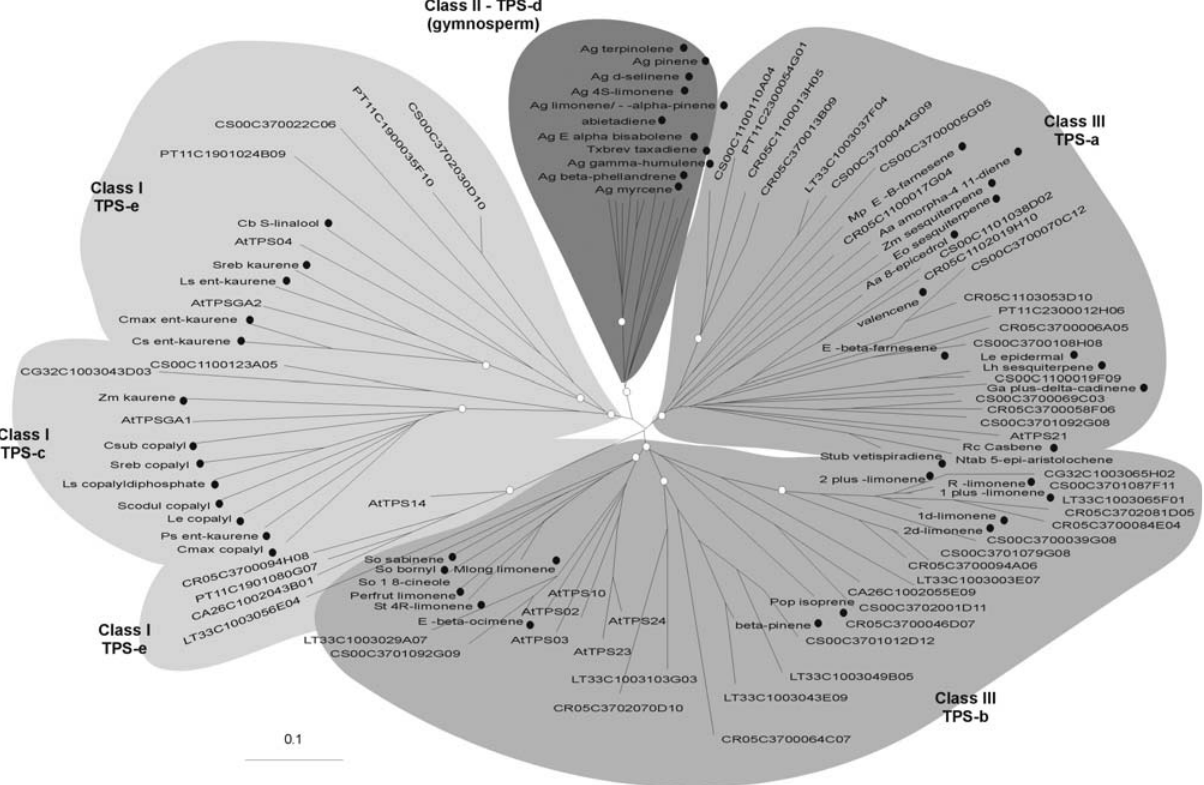
Figure 3 - Phylogenetic tree of the Citrus putative terpene synthase family members, the Arabidopsis terpene synthase family (AtPS) and representative terpene synthases of known function from diverse plant species. The neighbor-joining tree was generated from an alignment of 16 AtTPS and 43 docu- mented terpene synthases from 25 different plant species. Nodes supported by bootstrap values higher than 700 out of 1000 replicates are marked in yel- low. Subfamilies have previously been defined (Bohlmann et al. , 1998; Aubourg et al. , 2002). For designation of the AtTPS genes see Aubourg et al. (2002). CA: Citrus aurantium ; CG: C. aurantifolia ; CR: C. reticulata ; CS: C. sinensis ; LT: C. latifolia ; PT: Poncirus trifoliata . Accession numbers for other TPS represented in the phylogenetic tree are: Abies grandis abietadiene synthase (U50768); A.grandis (E)- α -bisabolene synthase